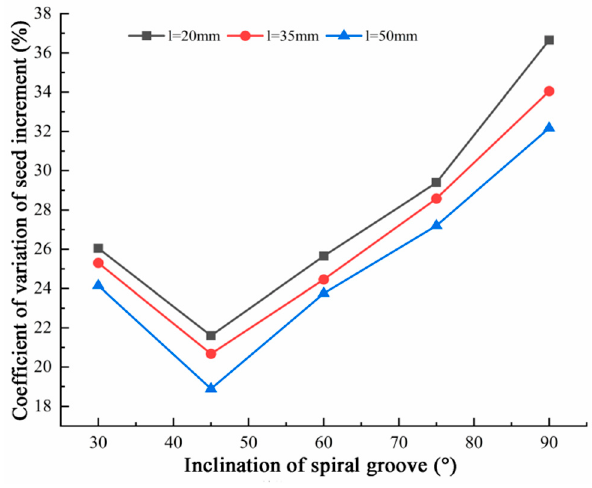
Figure 10. Effect of spiral groove inclination on variation coefficient of seed increment.